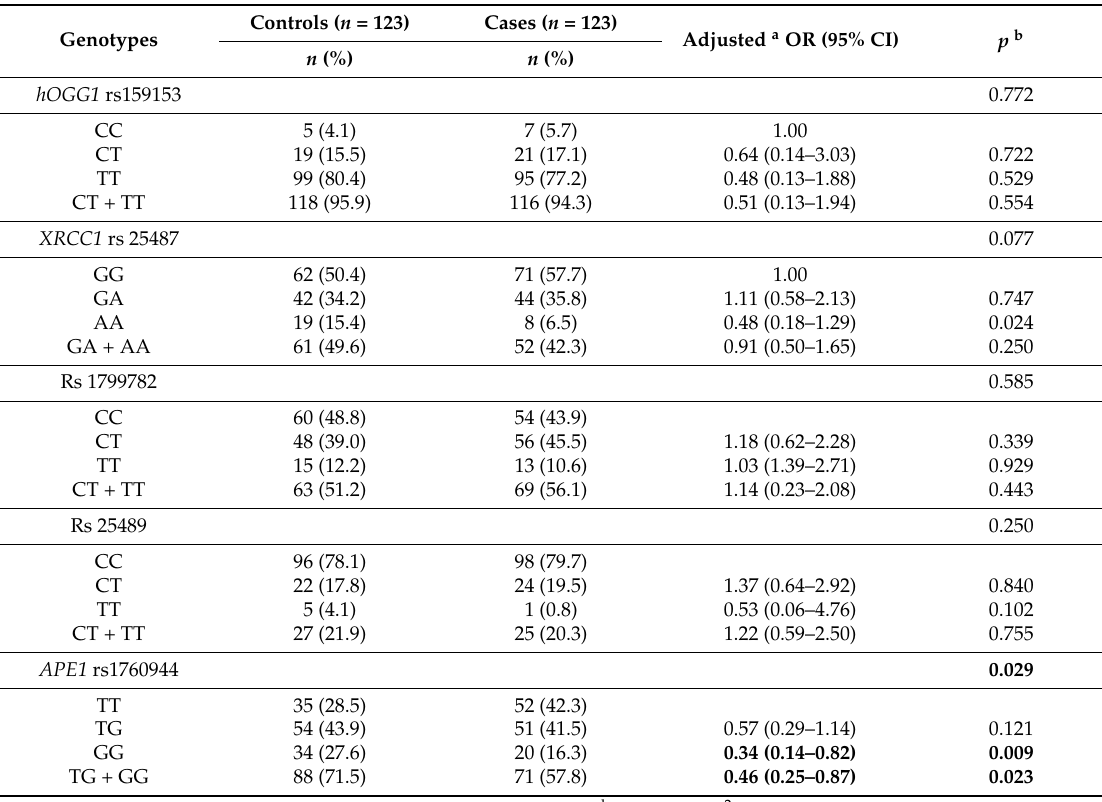
Table 2. Associations of hOGG1, APE1, XRCC1 polymorphisms with the risk of DMF-induced abnormal liver